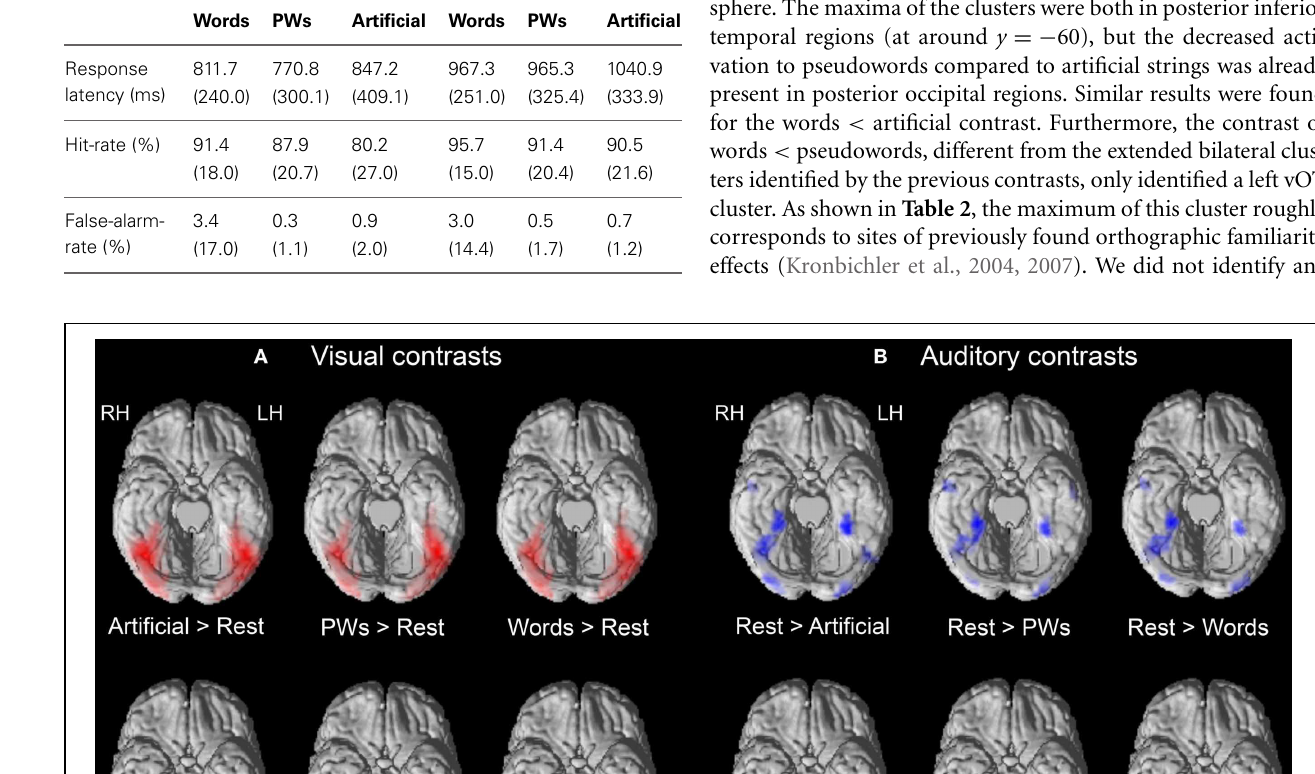
FIGURE 1 | Brain activations for visual (A) and auditory (B) contrasts of interest. The upper row depicts contrasts against rest baseline. Positive and negative activations are depicted in red and blue, respectively. The lower row depicts results of contrasting the stimulus types with each